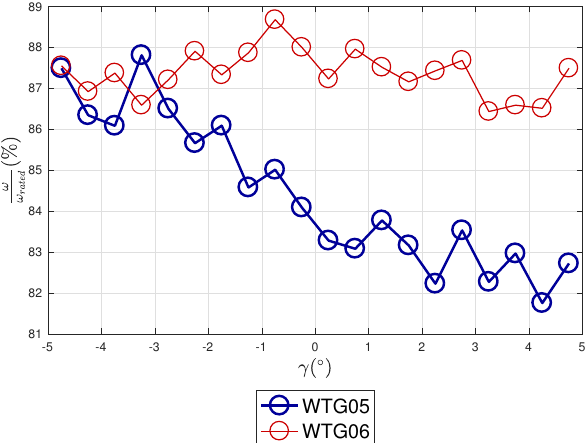
Figure 6. The yaw error–rotor speed curve for WTG05 and a sample reference wind turbine (WTG06): [7, 8] m/s wind speed interval. Data set D bef .